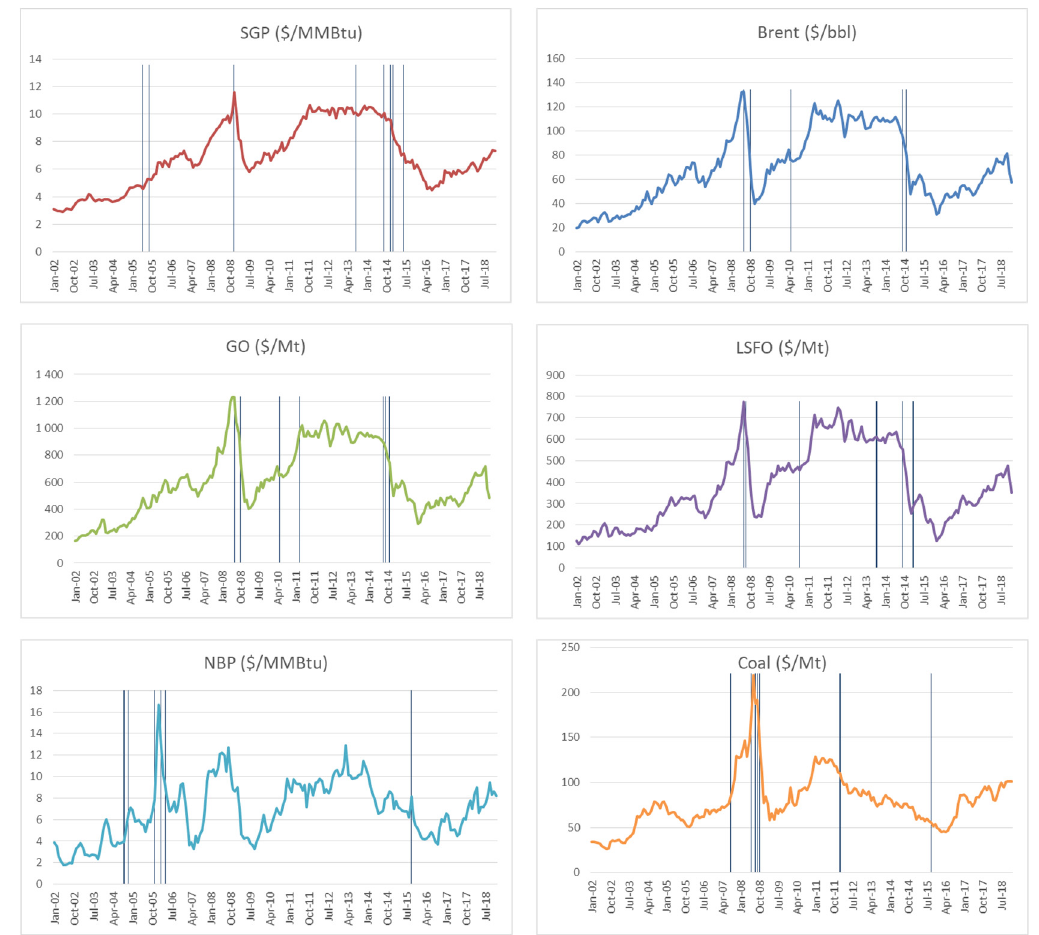
Figure 5. Break dates mixed model.